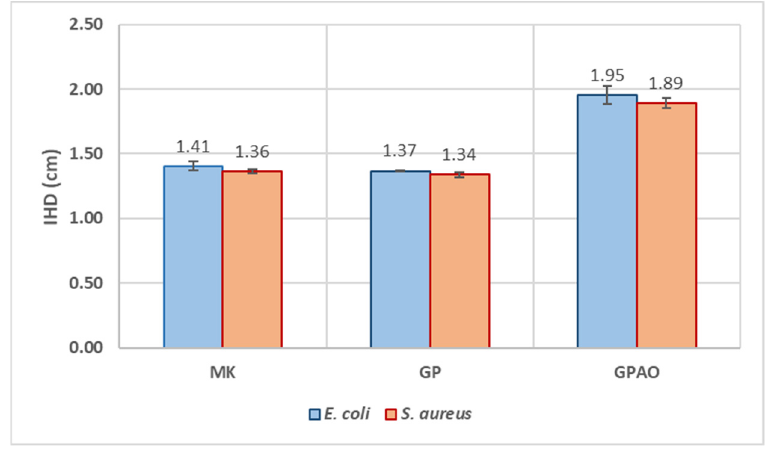
Figure 9. IHD values of MK, GP, and GPAO assayed in the presence of E. coli and S. aureus .